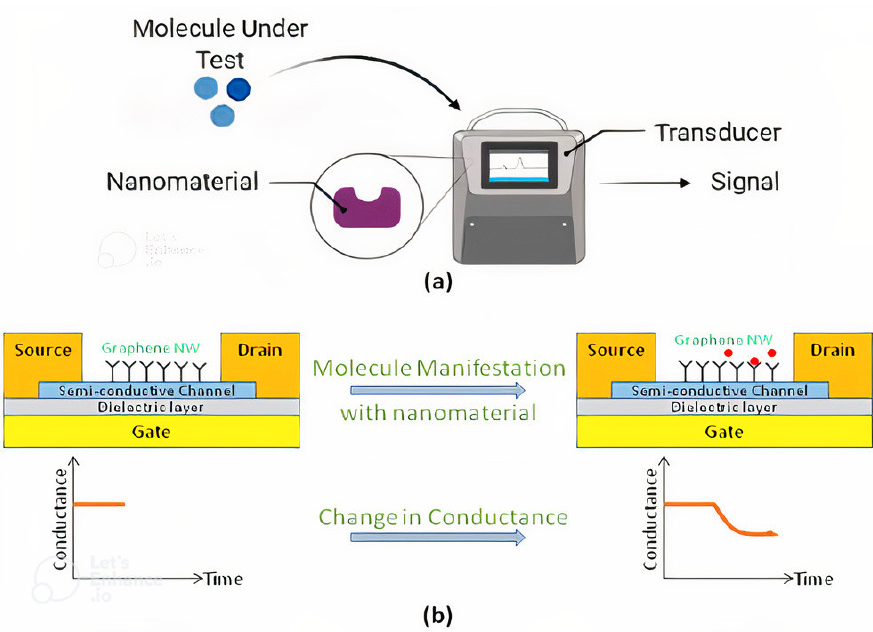
Figure 8. Chemical sensor ( a ) setup and ( b ) mechanisms.